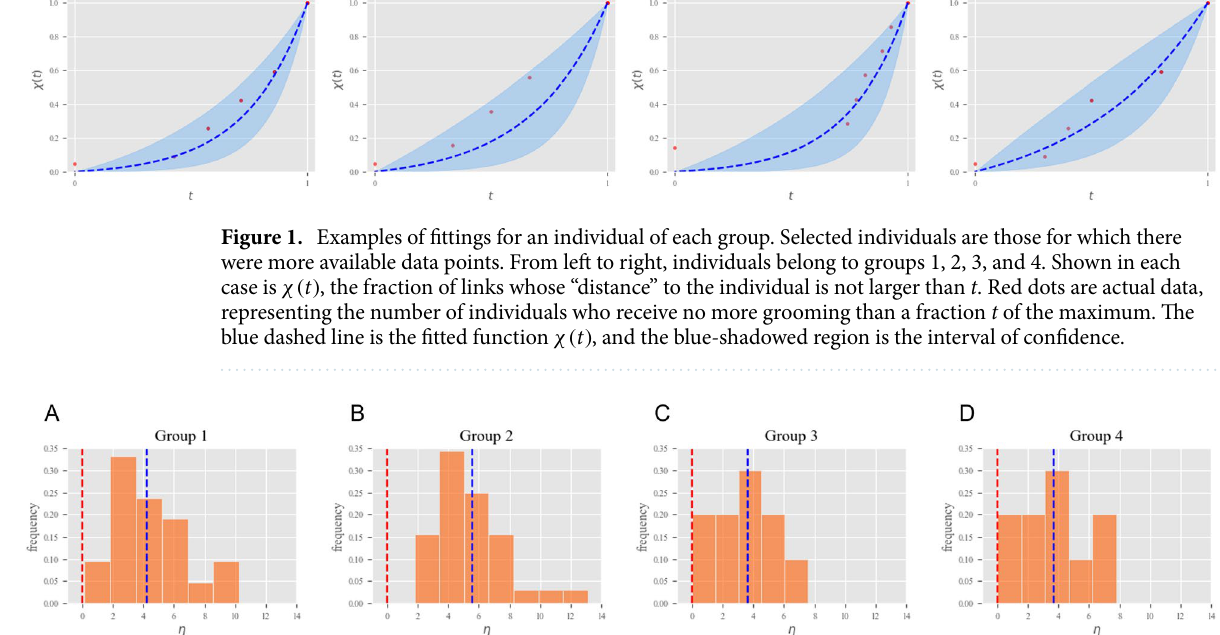
Figure 2. Histograms for η parameter distribution in each group. The red dashed line represents the change of regime η = 0 and the blue dashed line the mean value for each